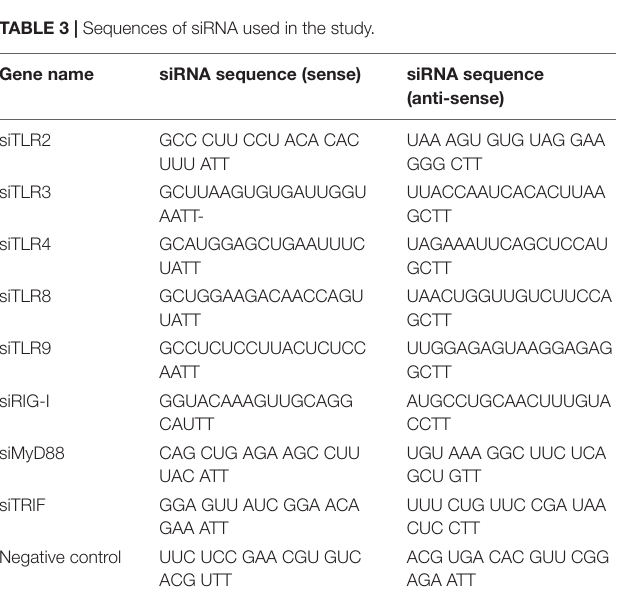
TABLE 3 | Sequences of siRNA used in the